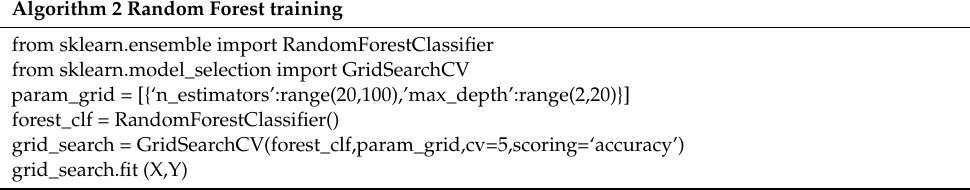
Algorithm 2 Random Forest training